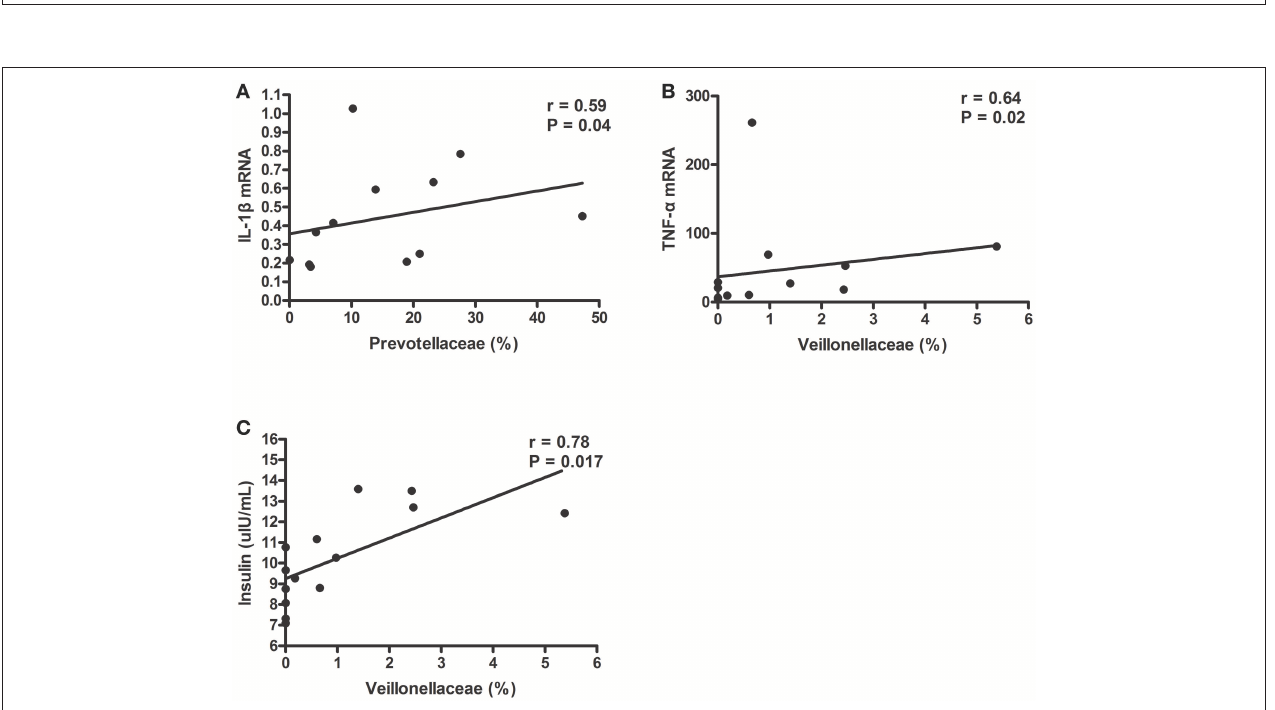
FIGURE 6 | Gut microbiota taxa correlated with insulin and inflammation parameters in TRIM31 − / − mice. (A) Correlation of Prevotellaceae proportion with caecal IL-1 β mRNA level. (B) Correlation of Veillonellaceae proportion with caecal TNF- α mRNA level. (C) Correlation of Veillonellaceae proportion with higher serum insulin level. Correlation analyses involved Spearman’s correlation analyses. n = 7, in each group. TNF- α , tumor necrosis factor- α ; IL-1 β , interleukin-1 β .